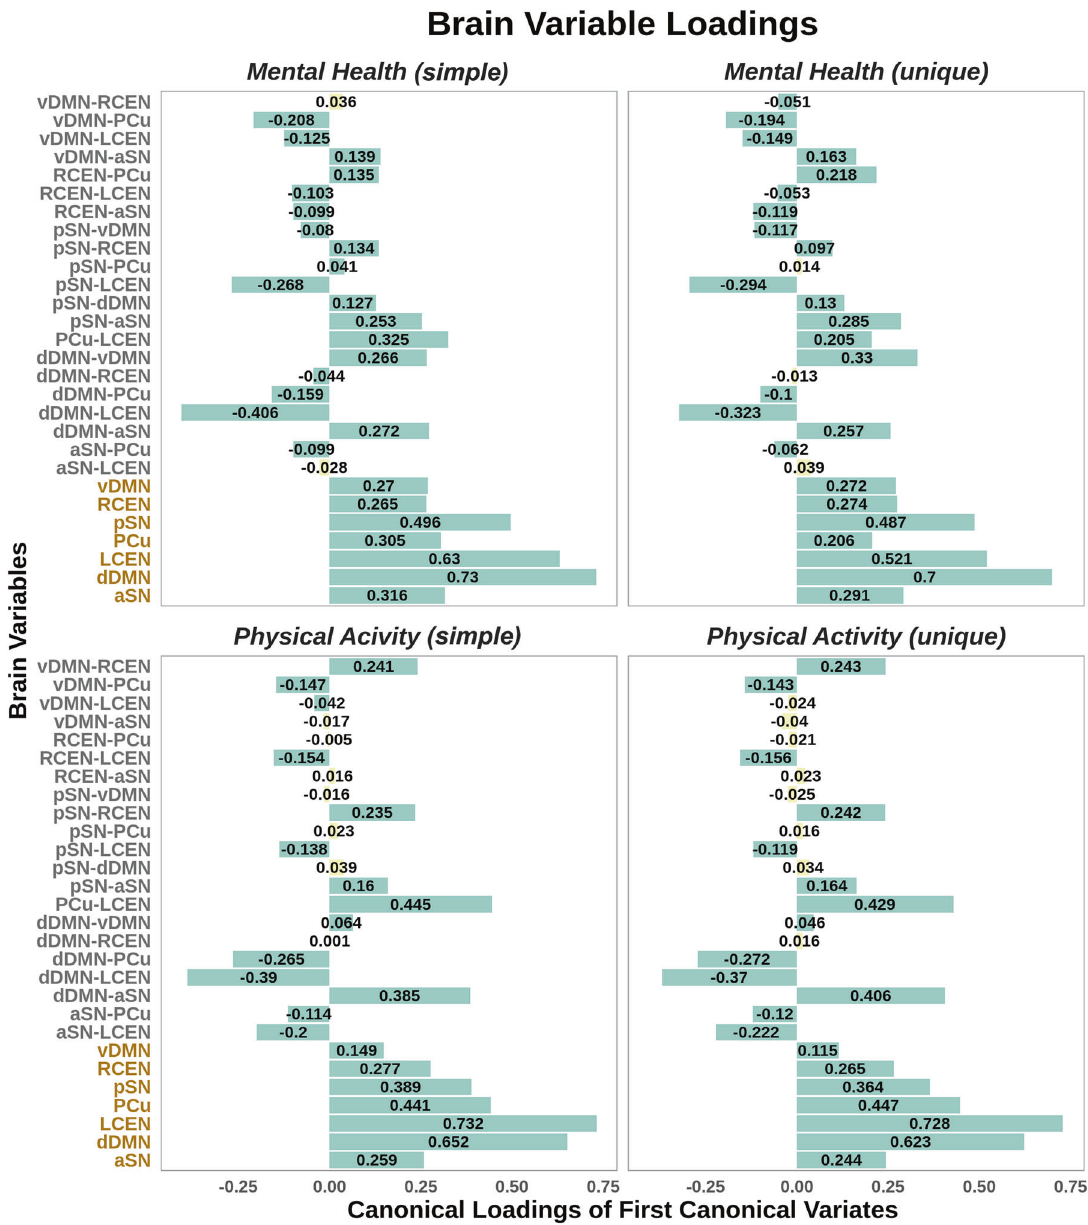
Fig. 2 Canonical loadings of brain measures on the fi rst canonical variate pair. These loadings represent the linear correlation between the original brain measures (Y) and the fi rst canonical variate pair (U) per model. Color coding was made for brain variable names along the Y axis (i.e., subnetwork edges in gray with “ - ” between subnetwork names and amplitude in orange), and for the bars representing canonical loadings (i.e., signi fi cance in cyan, insigni fi cance in yellow). Simple and unique models differ in whether the model accounted for the shared variance in brain measures between mental health and physical activity. vDMN ventral default mode network, R/L CEN right/left central executive network, PCu precuneus, a/p SN anterior/posterior salience ( p = 1.03e-04, FDR-corrected p value = 1.03e-04) for sleep dura- tion and walking, to 0.796 ( p = 1.77e-31, FDR-corrected p value = 8.85e-31) for moderate and overall activity (Fig. 3). Physical activity phenotypes adjusted for sex and BMI largely recapitulated these results, with genetic correlations ranging from − 0.209 ( p = 2.49e-04, FDR-corrected p value = 2.49e-04) for sleep dura- tion and walking, to 0.780 ( p = 2.12e-23, FDR-corrected p value = 1.06e-22) for moderate and overall activities.